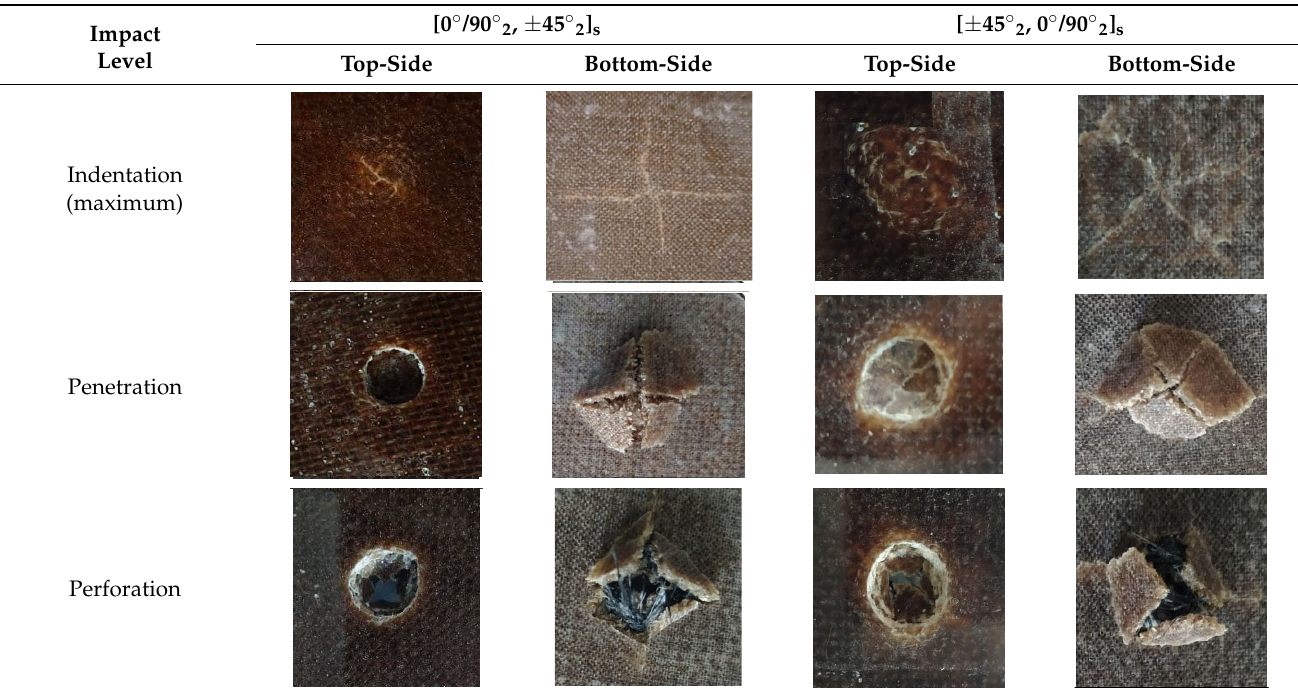
Table 6. Damaged areas of the PCCP at ply orientations of [0 ◦ /90 ◦ 2 , ± 45 ◦ 2 ] s and [ ± 45 ◦ 2 , 0 ◦ /90 ◦ 2 ] s .